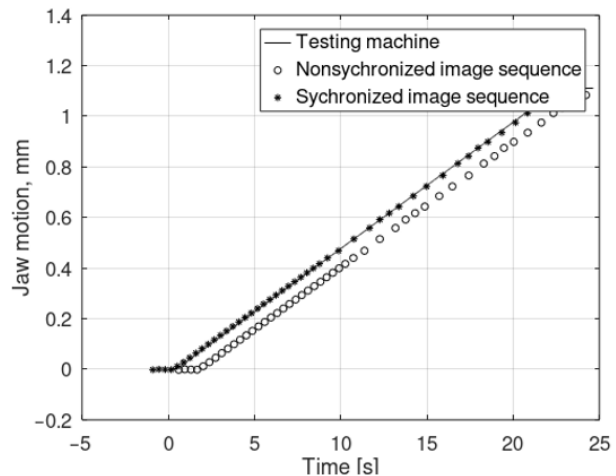
Figure 8. Displacement of the handle of the testing machine estimated from a series of images before and after synchronization with data from the machine.